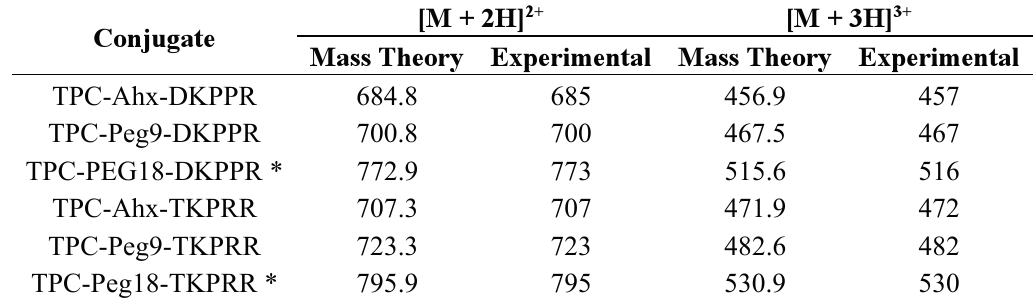
Table 1. Mass Spectrometry-Electron Spray Ionization (MS-ESI) values of TPC–peptide conjugates. Conjugate Mass Theory Experimental Mass Theory